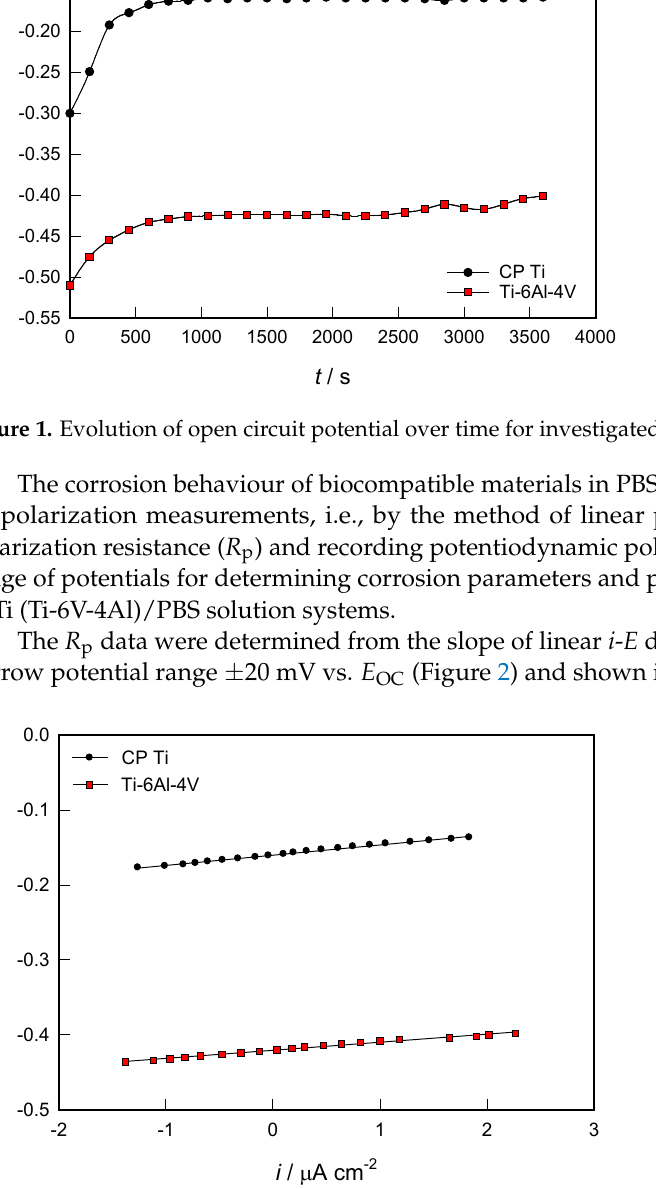
Figure 1. Evolution of open circuit potential over time for investigated samples in PBS solution .